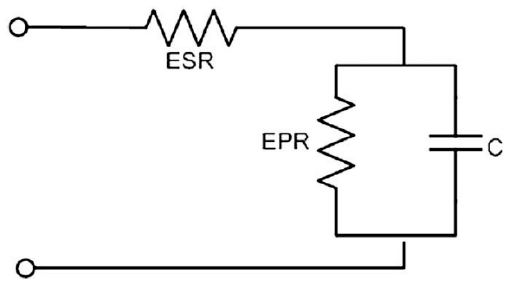
Figure 10. Electrical equivalent circuits for the SC.